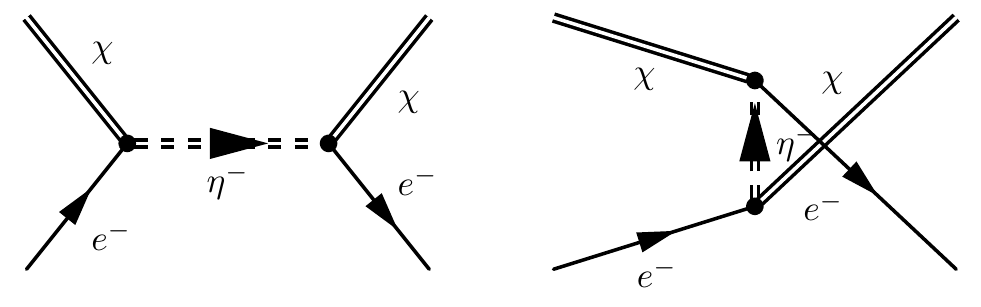
Figure 7 . Feynman diagrams contributing to the scattering of right-handed neutrino DM ( (cid:31) = N 1 ) o(cid:11) electrons ( e (cid:0) ) through s - and u -channel exchanges of the charged Z 2 -odd scalars ( (cid:17) (cid:0)